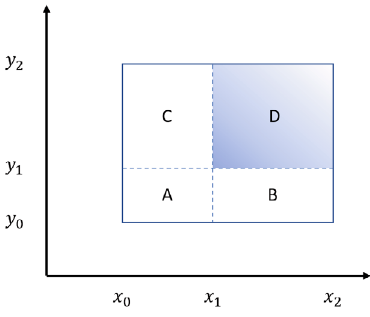
Fig. 1 The various control regions and the signal region ( D ) of the ABCD method